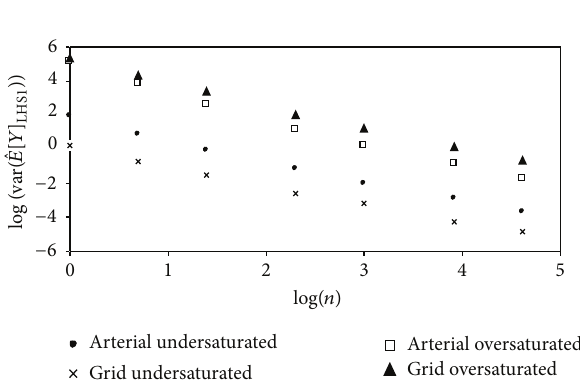
Figure 6: Approximately linear